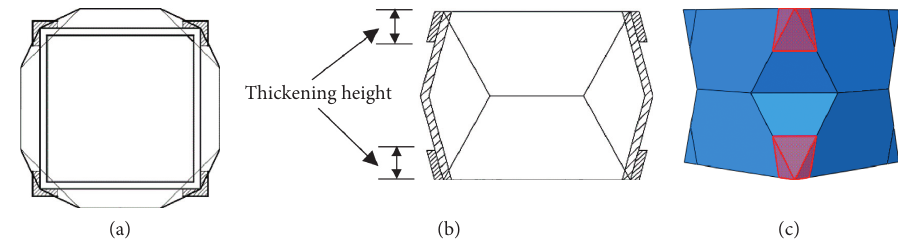
Figure 10: Thickened position of the device. (a) Top view, (b) main view, and (c) thickened area.